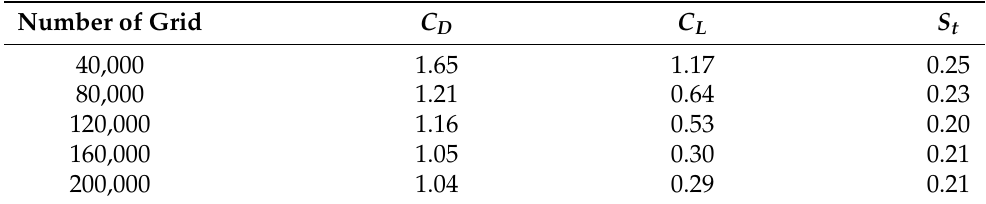
Table 1. Sensitivity study on the number of grids for simulations on a single circular cylinder at the Reynolds number of Re = 3900.